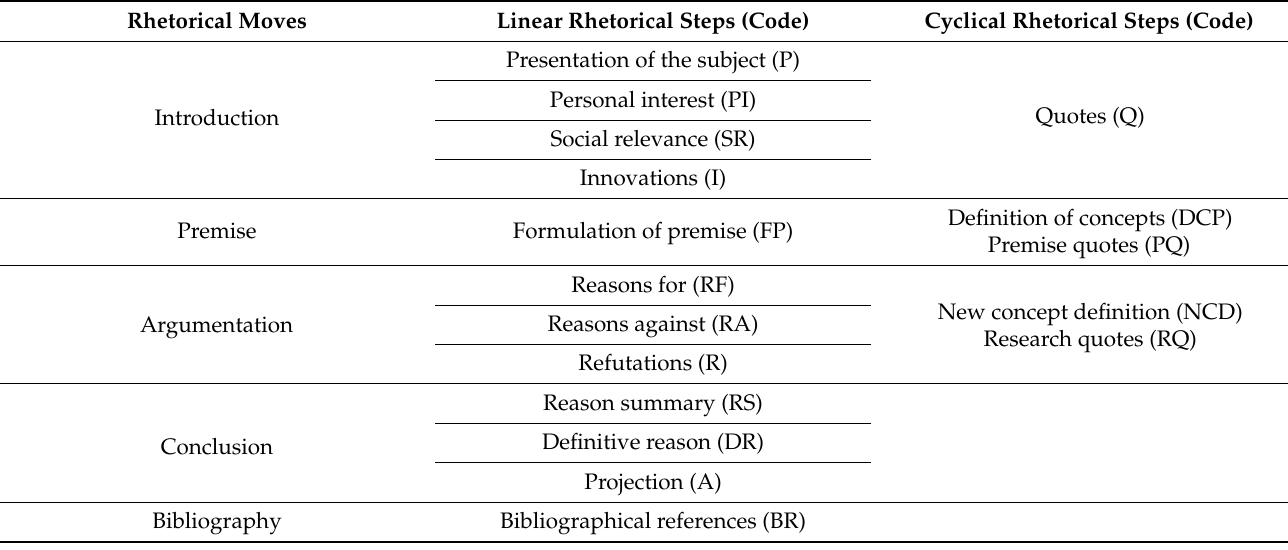
Table 8. Linear–cyclical structure of the argumentative